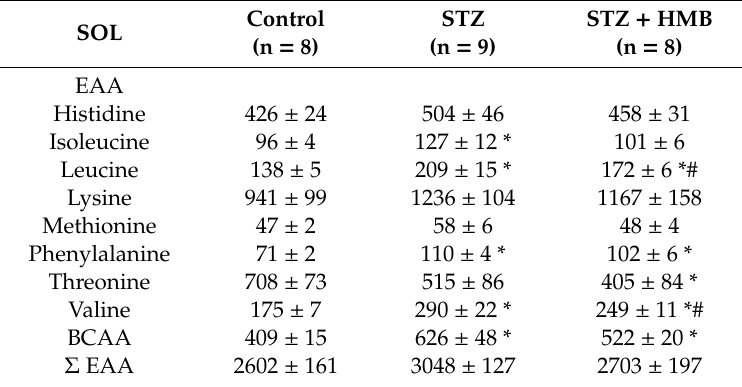
Table 5. Amino acid concentrations in soleus (SOL)